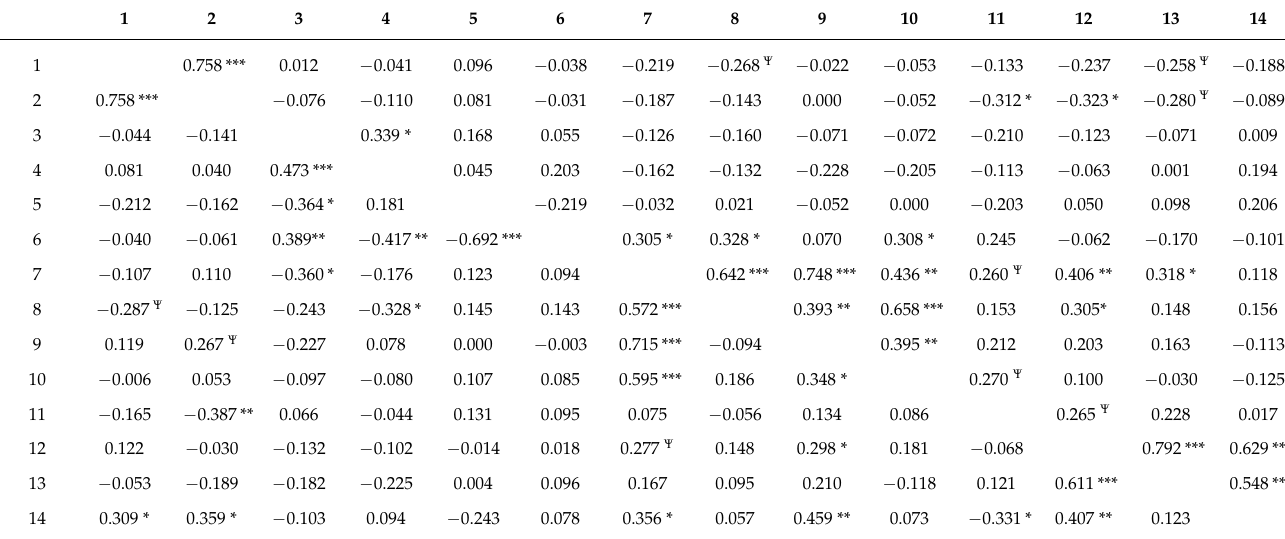
Table 2. Pearson’s correlations among measures for averaged data (below the diagonal line) and measures for consistency (above the diagonal line).